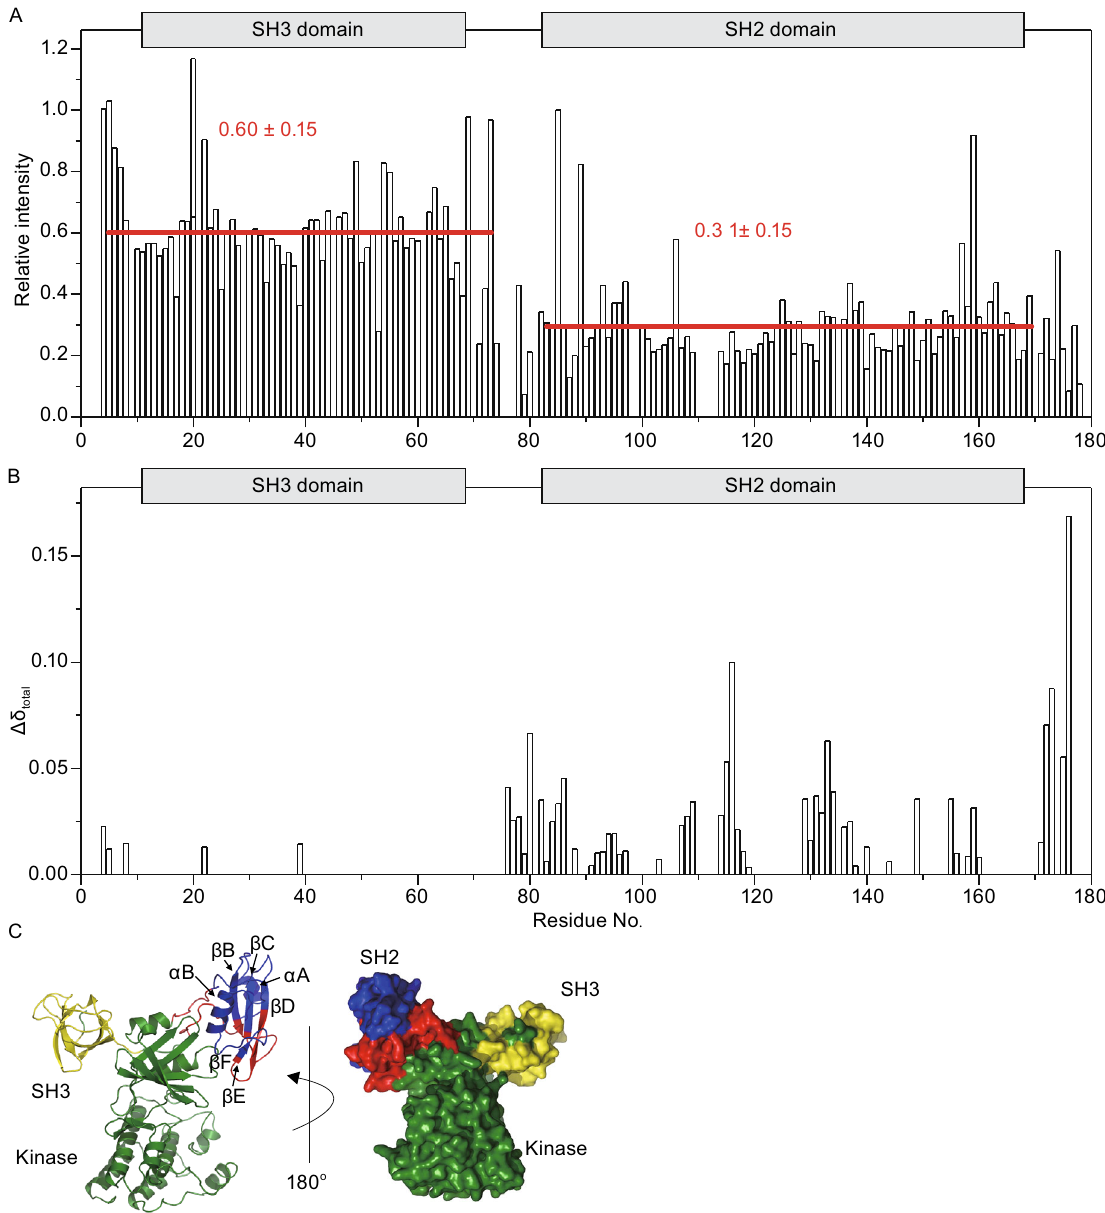
Figure 2. Structural perturbation observed via segmental labeling methods . (A) Changes on peak intensity of the SH32 domain with and without ligated kinase domain. The peak intensity of I4 is normalized to 100%. The average relative peak intensity of SH2 (31%) is only half of the SH3 (60%) domain, thereby suggesting a different interaction mode for these two domains. The locations of the SH3 and SH2 domains are indicated above the plot. (B) The combined chemical shift change of a particular residue upon ligation with the kinase domain. (C) Chemical shift perturbation mapped onto the crystal structure of Csk (1K9A - A). The red regions are the regions that undergo a big chemical shift change before and after SH32 ligation with the kinase